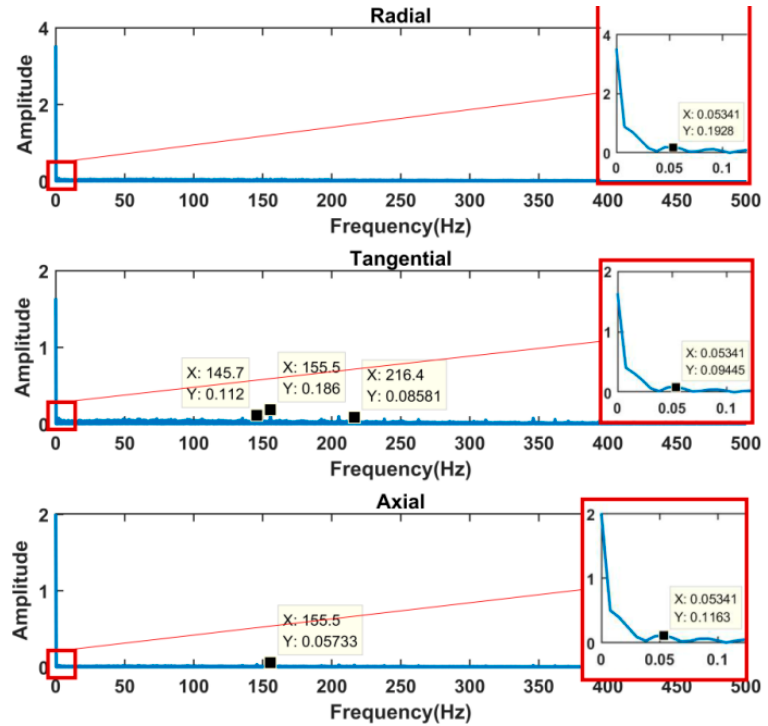
Figure 15. Triaxial acceleration spectrum of whirl.